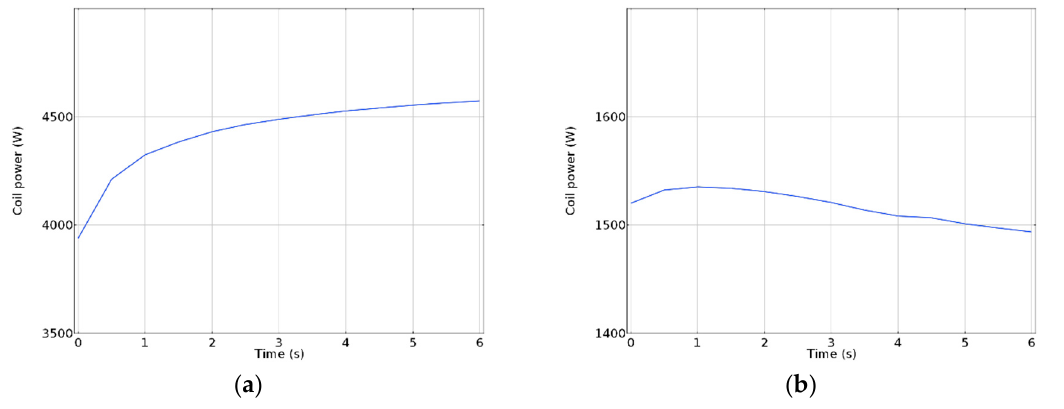
Figure 9. Coil power, ( a ) copper, ( b ) stainless steel.